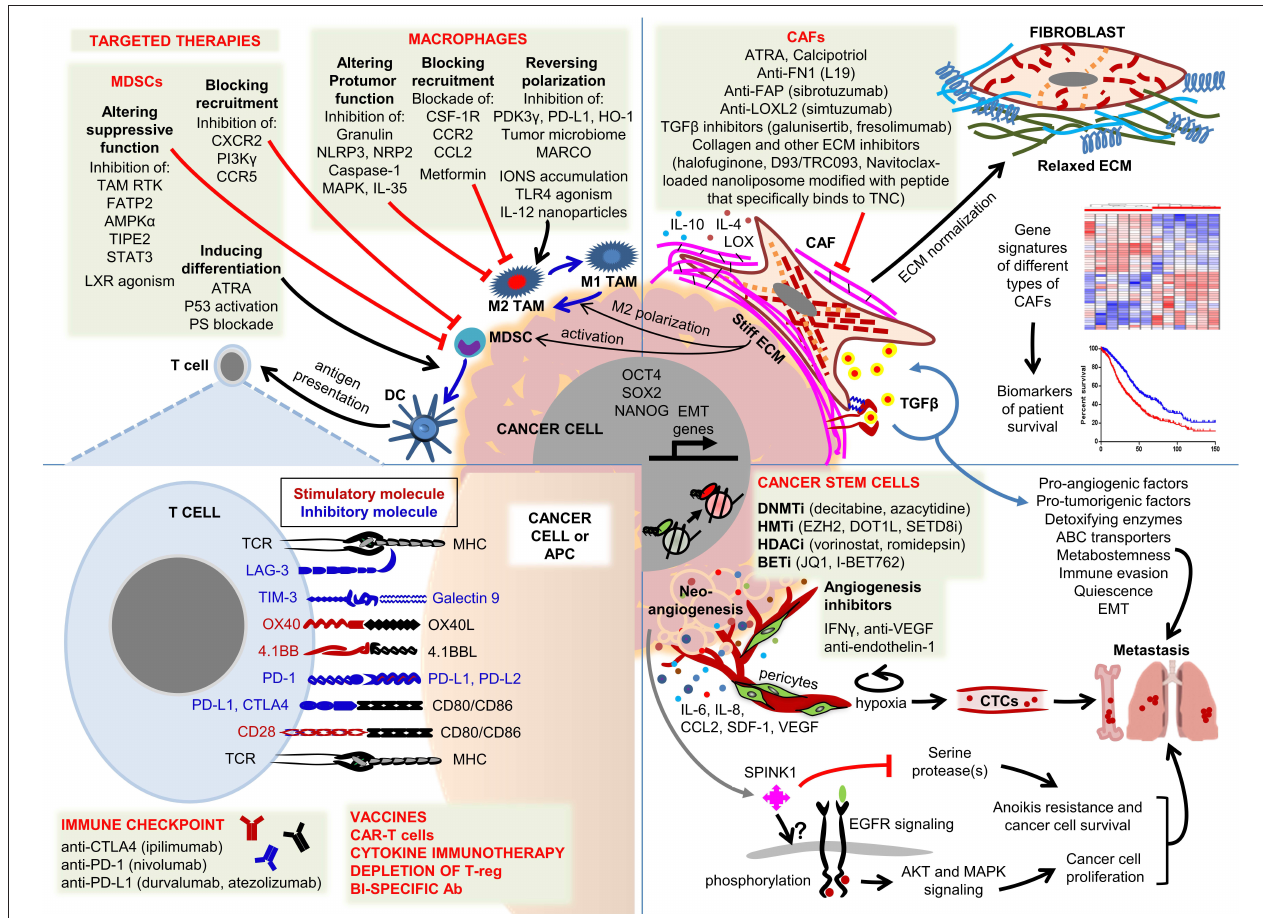
FIGURE 1 | Overview of the components of the tumor microenvironment and current strategies to target these cells. Malignant cells establish early cross-communications with a wide range of host cells forming a favorable microenvironment consisting of fibroblasts, immune cells, ECM, endothelial cells and pericytes. While infiltration of T lymphocytes is a good prognostic factor, the majority of invasive/metastatic carcinomas establish immunosuppressive and tumor-promoting TMEs. The complex interaction between the tumor cells and the other components within the TME is illustrated and the following abbreviations are used. ABC transporter, ATP binding cassette transporter; Ac, acetylation; APC, antigen presenting cell; ATRA, all trans retinoic acid; BETi, bromodomain inhibitors; CAF, cancer-associated fibroblast; CAR-T-cell, chimeric antigen receptor T cell; CTC, circulating tumor cell; DC, dendritic cell; DNMTi, DNA methyltransferase inhibitors; ECM, extracellular matrix; EMT, epithelial-mesenchymal transition; HDACi, histone deacetylase inhibitors; HMTi, histone methyltransferase inhibitors; MDSC, myeloid-derived suppressor cell; Me, methylation; MHC, major histocompatibility complex; TAM, tumor associated macrophage; TCR, T-cell antigen receptor; Treg, regulatory T